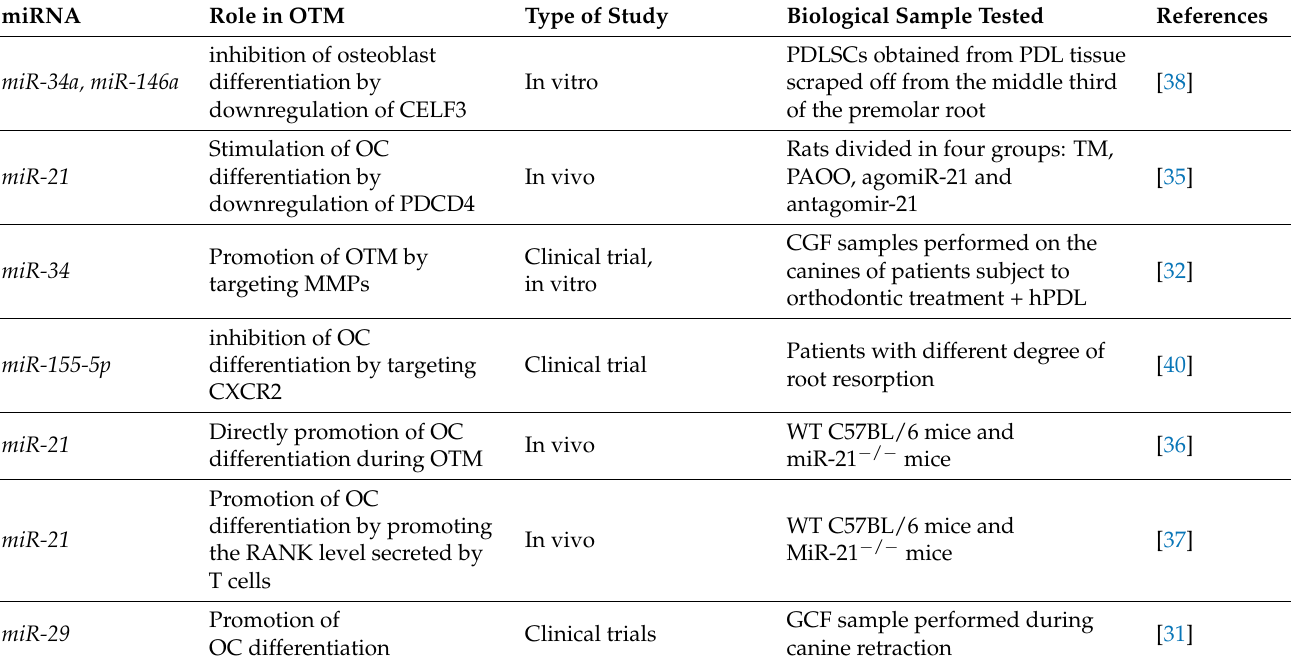
Table 1. Identified miRNAs in